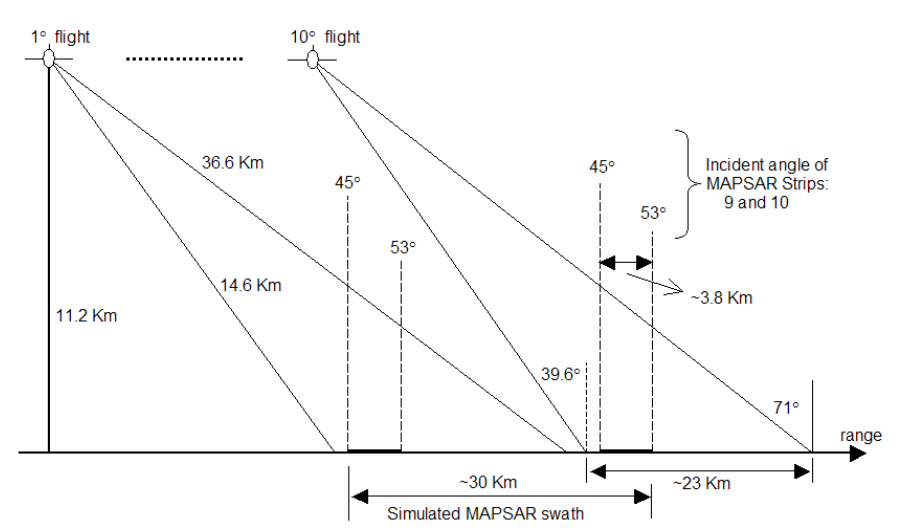
Figure 3. Flight geometry for the MAPSAR image simulation.